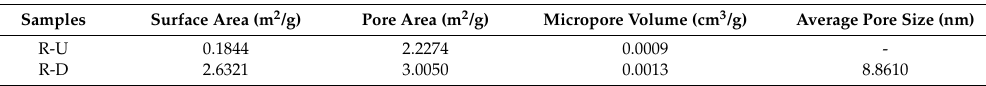
Table 5. The surface area, pore area, micropore volume and pore size of the untreated and desugared roots